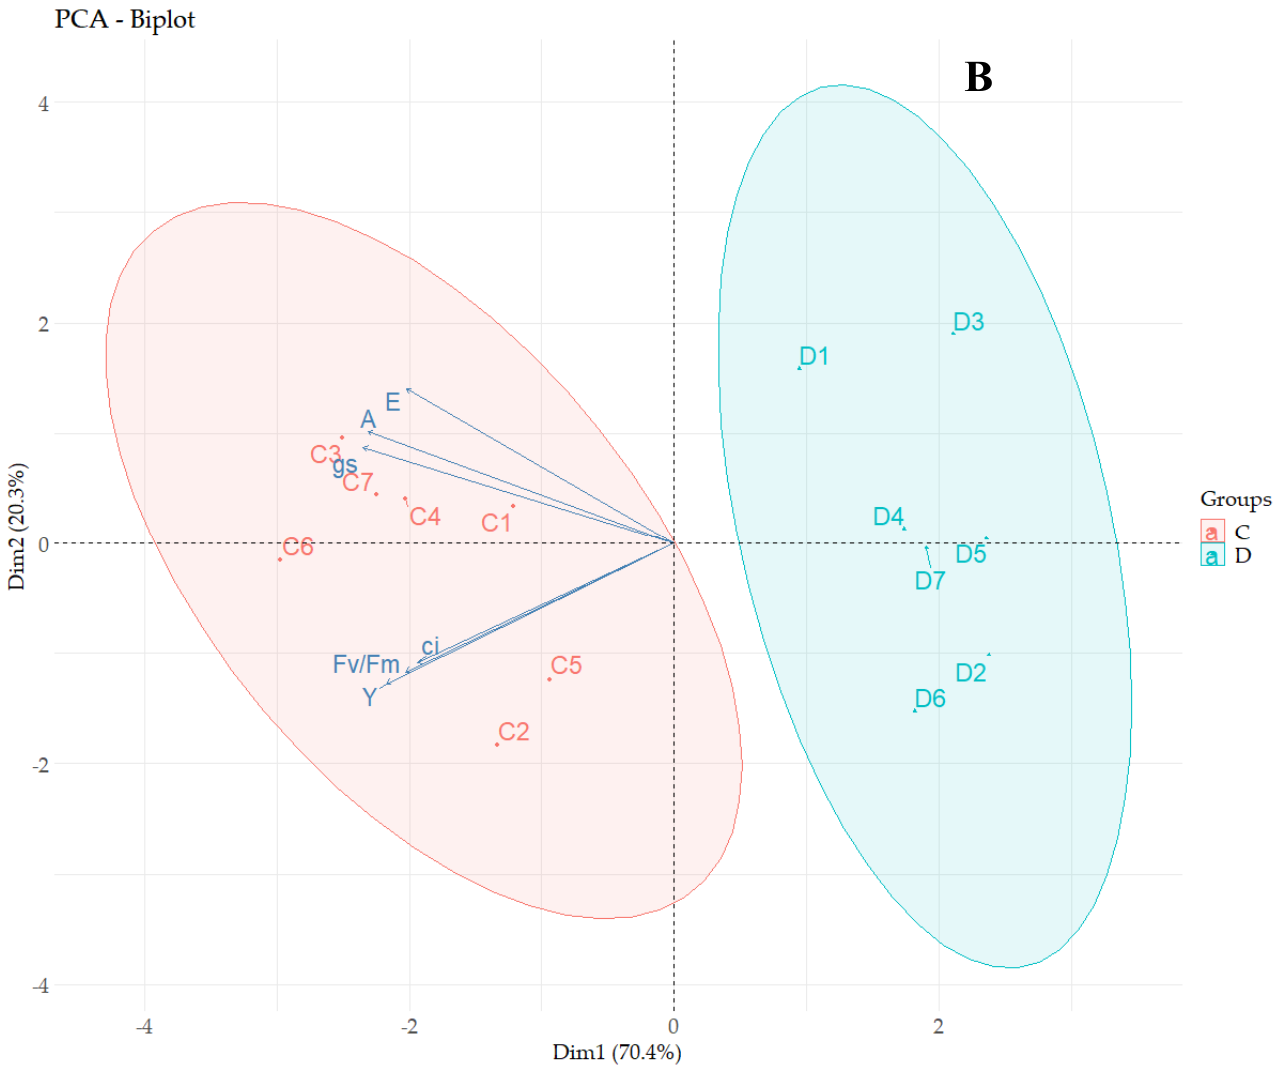
Figure 2. Projection of the variables on the component plane (1 × 2) of the effect of drought stress on: ( A ) relative water content (RWC), lipid peroxidation index (MDA), anthocyanins, and proline accumulation; ( B ) photosynthesis-related parameters (CO 2 assimilation level (A), transpiration rate (E), stomatal conductance (Gs), intercellular CO 2 concentration (Ci), maximum PSII quantum yield in the dark-acclimated state (Fv/Fm), PSII quantum yield in the light-acclimated state (Y (PSII)). C1–